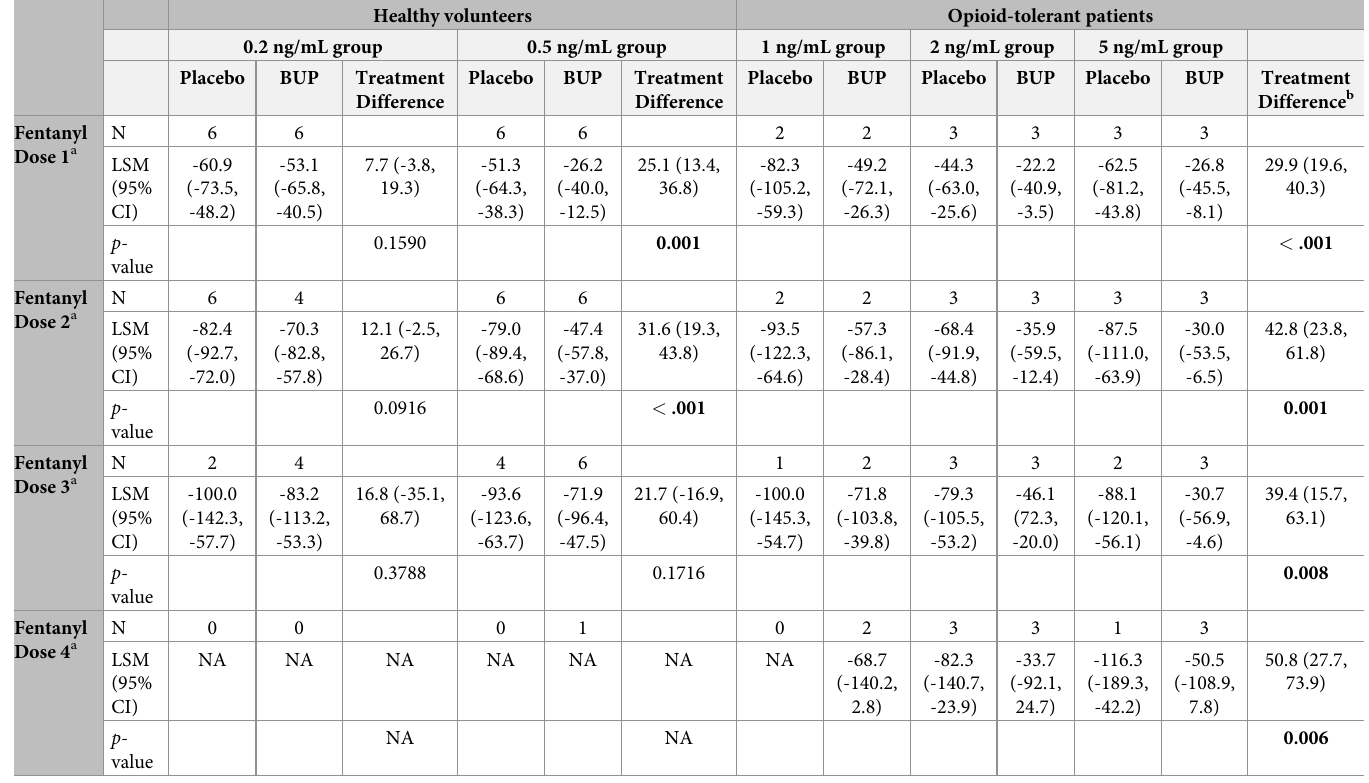
Table 3. Maximum decreases in minute ventilation after fentanyl bolus administration